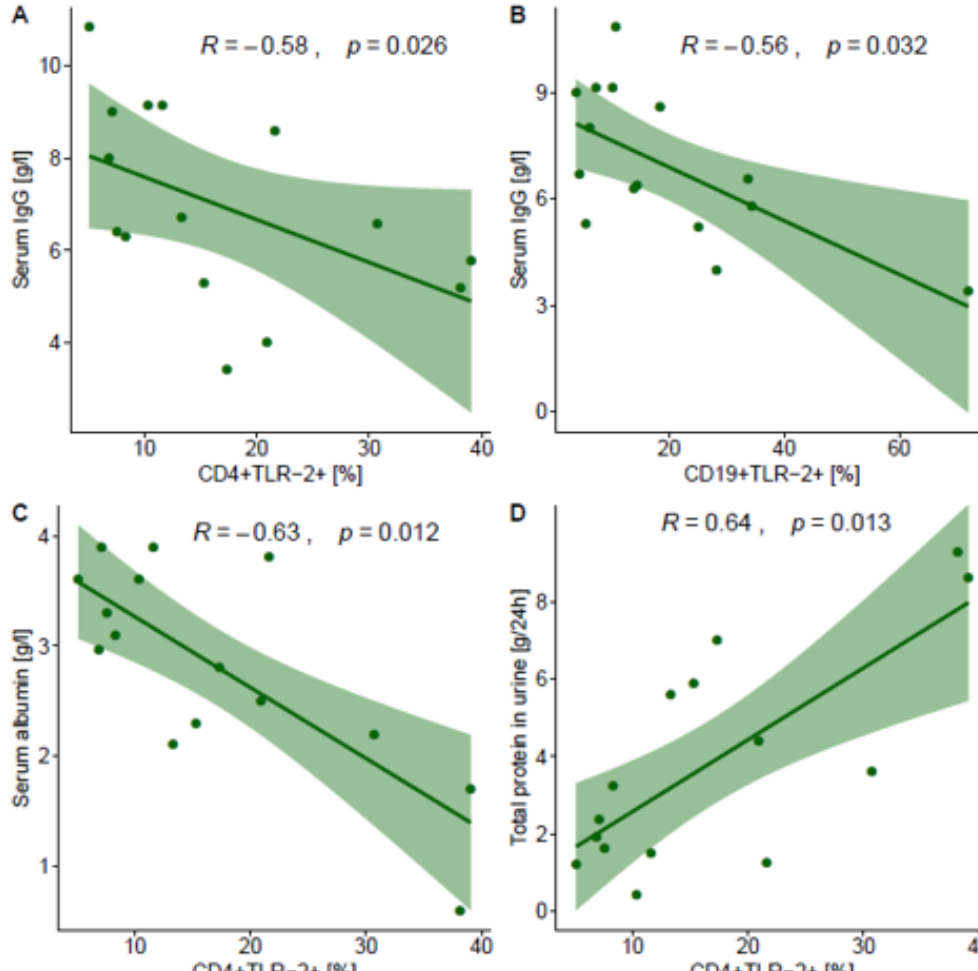
Figure 1. Correlation between the expression of TLR-2 and selected laboratory measures in patients with PGN. R: Spearman correlation coe ffi cient. ( A ). Correlation between the frequencies of CD4 + TLR-2 + cells and the concentration of IgG (rho = − 0.58, p = 0.026). ( B ). Correlation between the frequencies of CD19 + TLR-2 + cells and the concentration of IgG (rho = − 0.56, p = 0.032). ( C ). Correlation between the frequencies of CD4 + TLR-2 + cells and the concentration of albumin (rho = − 0.63, p = 0.012). ( D ). Correlation between the frequencies of CD4 + TLR-2 + cells and the urinary protein excretion (rho = 0.64, p = 0.013).